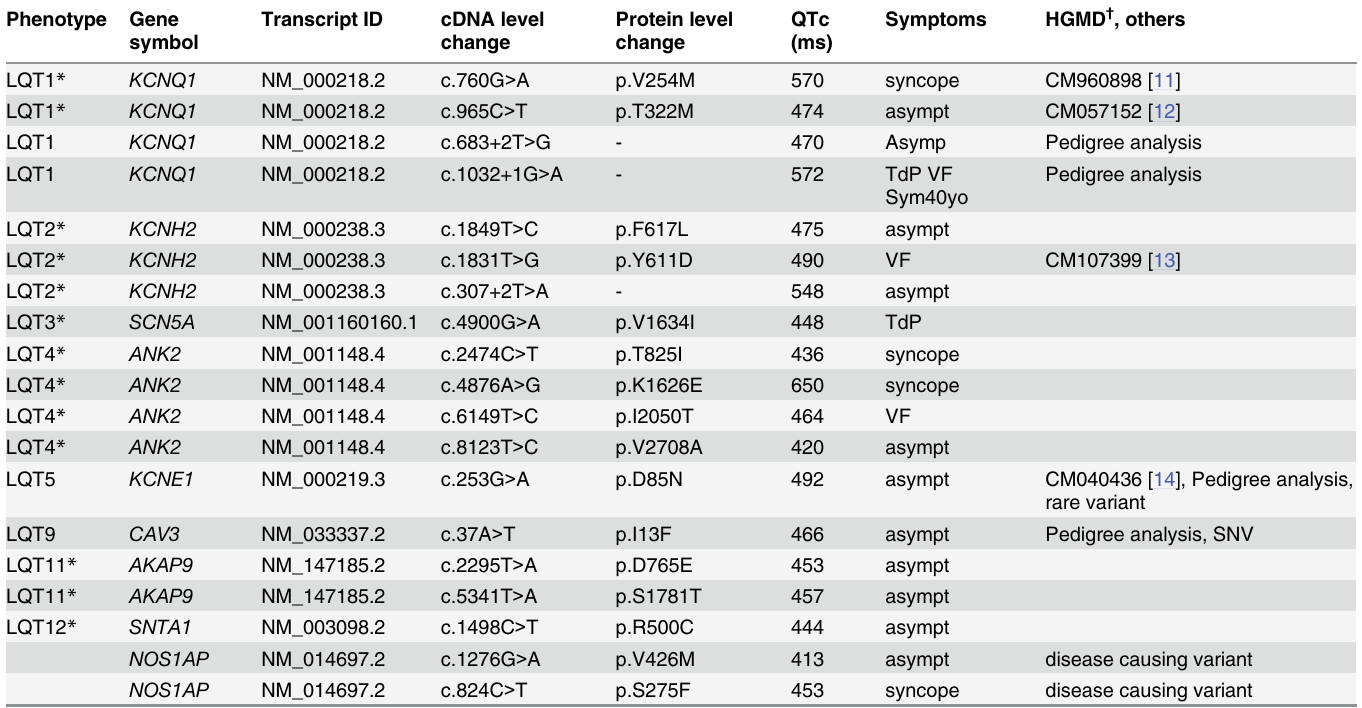
Table 1. Identification of known-gene and disease-causing variant in the LQTS.